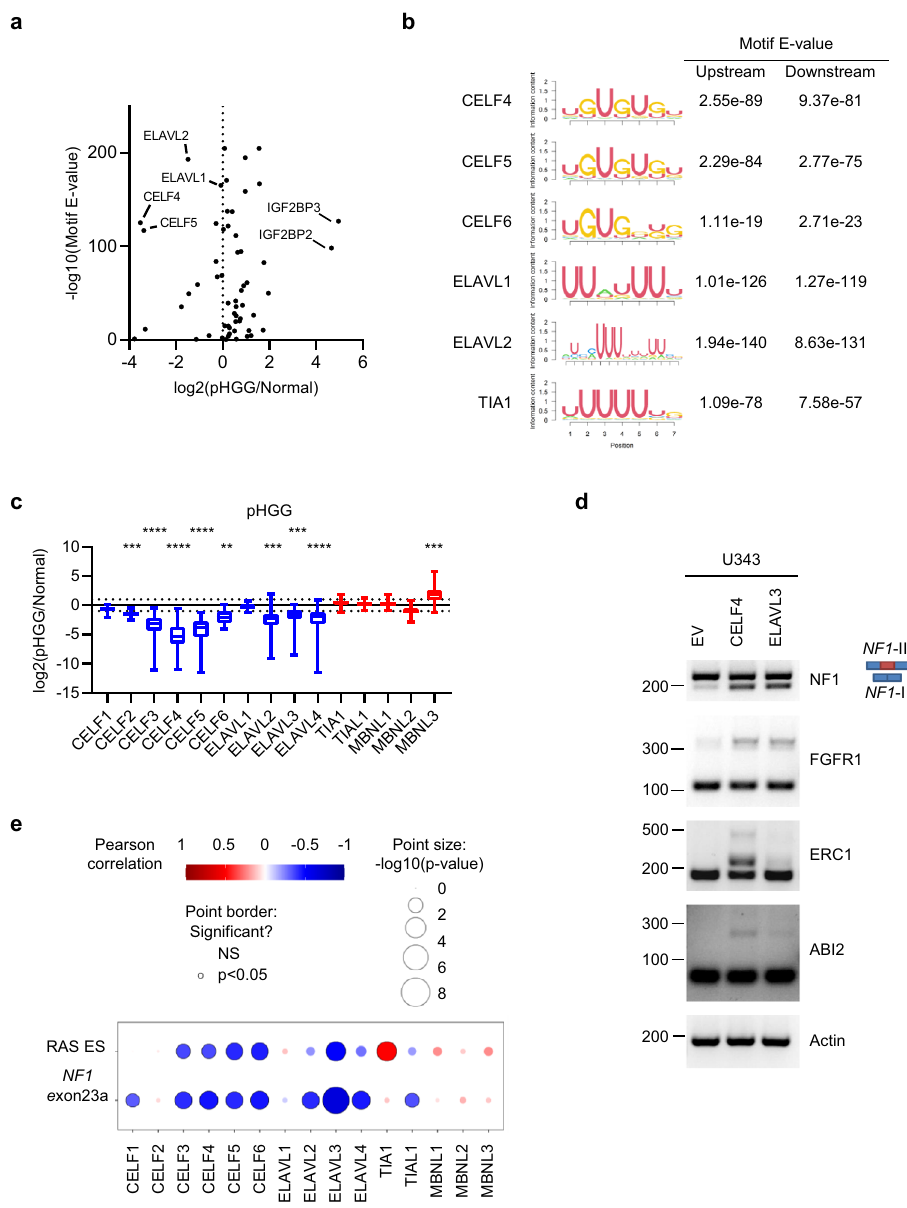
Fig. 6 NF1 exon23a splicing in HGG is controlled by differential expression of the CELF/ELAVL gene families. a Scatter plot comparing log2 fold change in expression between pHGG and normal brain of splice factors and RNA-binding proteins, with the enrichment of the RNA motifs they bind in introns surrounding differentially spliced exons in pHGG. b Motifs and enrichment in up- and downstream introns surrounding differentially spliced exons for the indicated splicing factors. c Expression ratio (log2 fold change) of negative (blue) and positive (red) NF1 exon23a splicing regulators between pHGG ( n = 64) and normal brain ( n = 20). Box shows IQR with the median marked, and the whiskers show the range. P values: CELF2, 0.0001; CELF3, 4 × 10 − 16 ; CELF4, 7 × 10 − 28 ; CELF5, 2 × 10 − 26 ; CELF6, 0.001; ELAVL2, 0.0003; ELAVL3, 0.0001; ELAVL4, 1.5 × 10 − 5 ; MBNL2, 0.01, MBNL3, 7 × 10 − 5 . d U343 GBM cells transduced with control (EV) lentivirus or expressing CELF4 or ELAVL3 were analyzed by RT-PCR for the indicated splicing events. Bands corresponding to NF1 -II (includes exon23a, red box) and NF1 -I are shown at the left. Gels are representative of two experiments. e Bubble plot showing the relationship between NF1 exon23a splicing regulators and NF1 exon23a inclusion and RAS activity score (ES, enrichment score from ssGSEA) in pHGG. Bubble color represents Pearson correlation, size is signi fi cant, and statistically signi fi cant correlations have a black border on the bubble. Statistical tests: t ( c , e ). * P < 0.05, ** P < 0.01, *** P < 0.001. Source data are provided as a Source Data fi NF1 exon23a splice regulators, which we con fi rmed for the same and is negatively associated with their repression (Fig. 7e), suggesting sites in CELF3 , CELF4, and ELAVL3 in three primary pHGG cell that it binds and represses their expression in pHGG. To test this lines by ChIP-qPCR (Fig. 7b and Supplementary Fig. S9g). hypothesis, we depleted REST from primary pHGG cells, fi nding REST was signi fi cantly upregulated in pHGG ( P < 0.0001) and, as signi fi cant increases in CELF3 , CELF4 , and ELAVL3 expression expected for a repressive transcription factor, expression of RE1 (Fig. 7f and Supplementary Fig. S9h). In turn, REST depletion caused motif-containing, REST-bound genes was highly downregulated a signi fi cant increase in NF1-I expression with an accompanying (Fig. 7c, d) 44 . In particular, REST directly binds most CELF/ELAV decrease in NF1-II (Fig. 7g). Consistent with this, increased REST